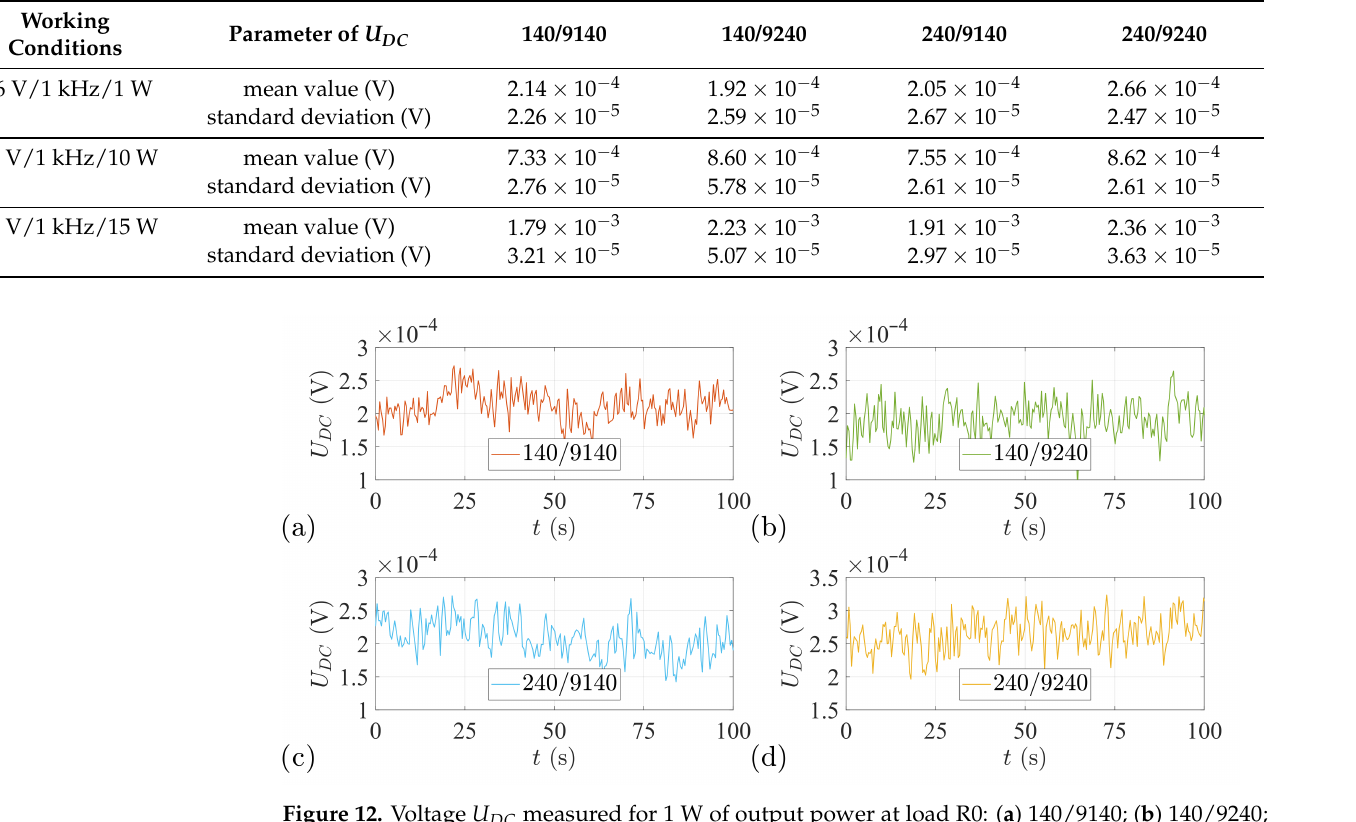
Figure 12. Voltage U DC measured for 1 W of output power at load R0: ( a ) 140/9140; ( b ) 140/9240; ( c ) 240/9140; and ( d ) 240/9240 transistor pair.